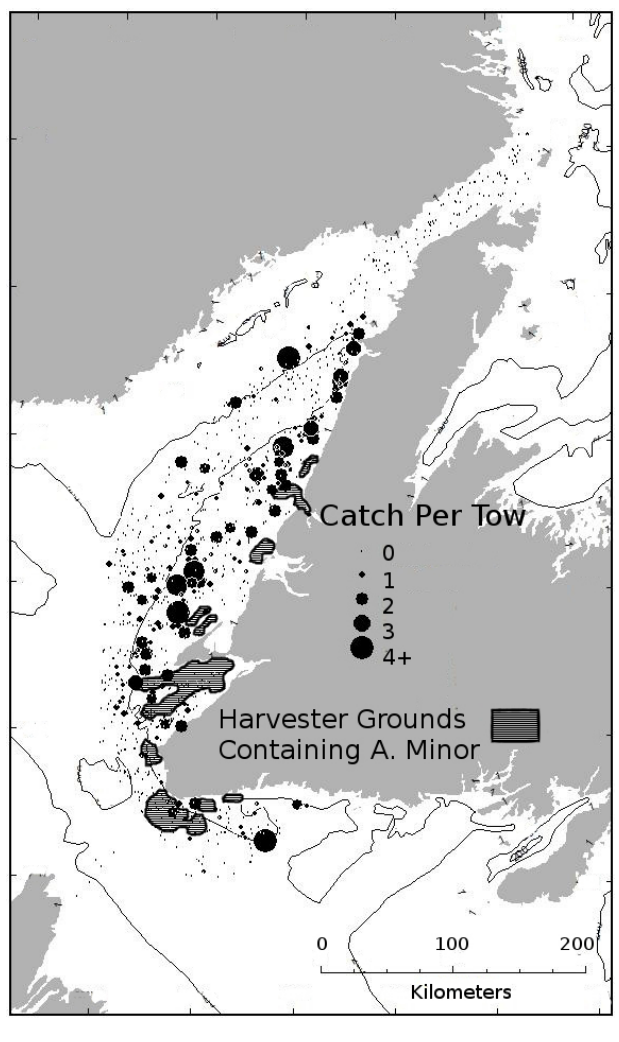
Fig. 2 . A comparison of fishery-independent data (bubble plot) and local ecological knowledge interview data (polygons) for Anarhichas lupus.